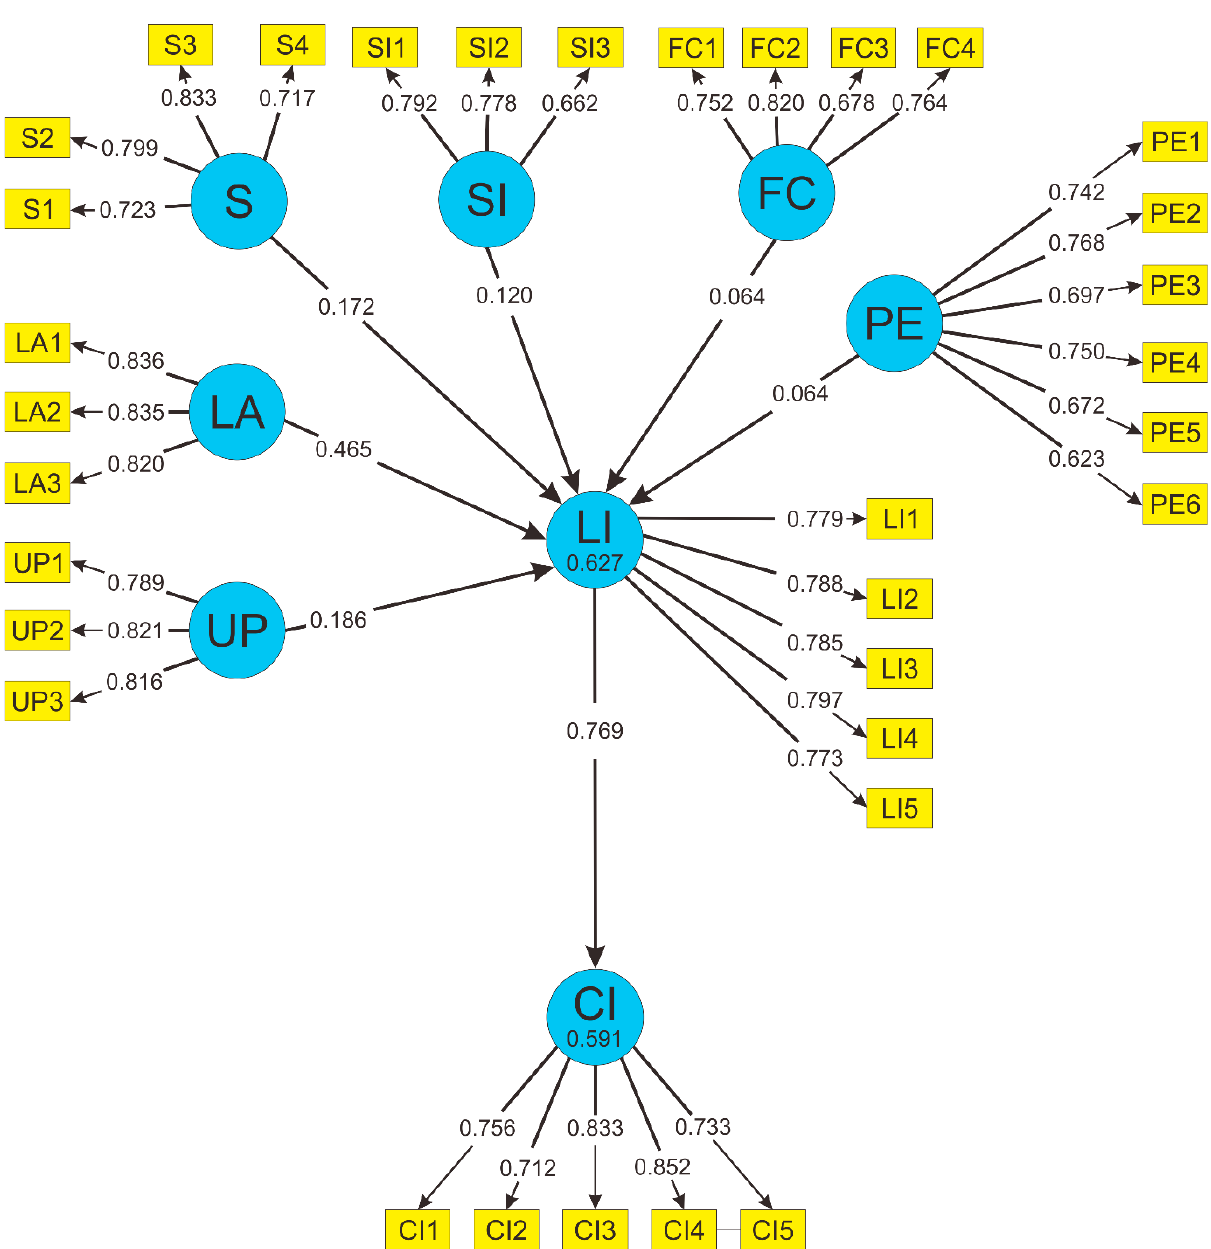
Figure 7. SEM with indicators of factors influencing womenpreneurs using mobile application.